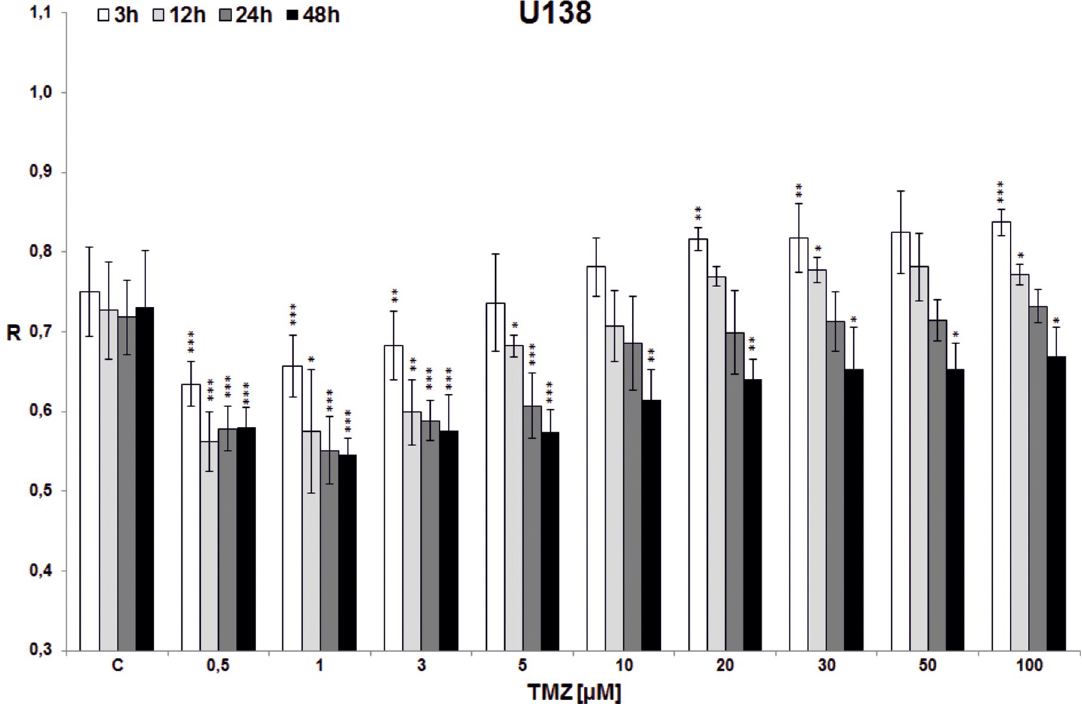
Fig 4. The effect of TMZ on total DNA methylation of U138 cell line. The analysis was performed after 3 (white bars), 12 (light grey bars), 24 (dark grey bars) and 48 (black bars) hrs of incubation in a given TMZ concentration (0.5–100 μ M). Control cells (C) were treated with DMSO only. The R values are means from three experiments ± SD. Asterisks indicate a significant difference ( � p < 0,05, �� p < 0,01, ��� p < 0,001) from the control (DMSO) value. A very little DNA hypermethylating effect is observed (for incubation times 3 and 12 hrs, over concentrations 20 and 30 μ M respectively). Very clear initial hypomethylation is seen in TMZ concentrations up to 100 μ M for incubation times of 24 and 48